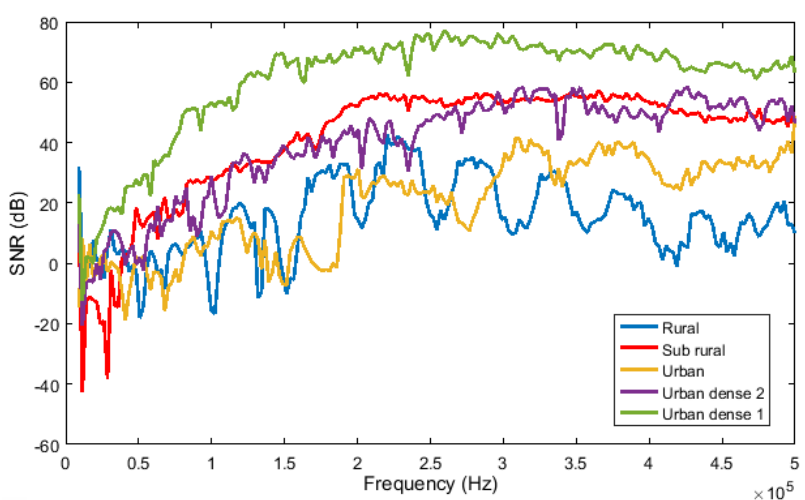
Figure 18. Calculated signal-to-noise (SNR) evolution depending on the frequency in the transformer substation.